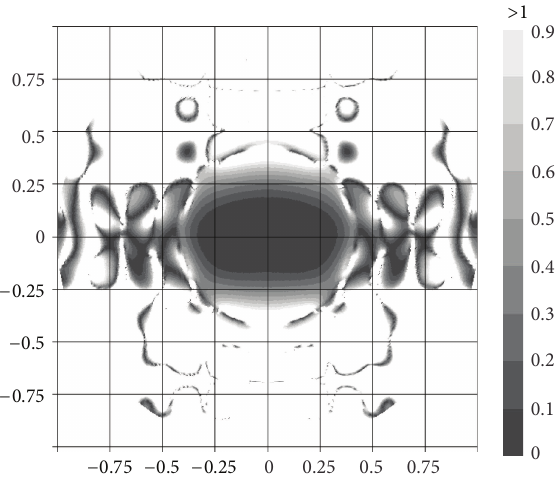
Figure 6: Contour plot (dB scale) of the 8 × 8 planar array with a circular radiation pattern in the u - v plane.